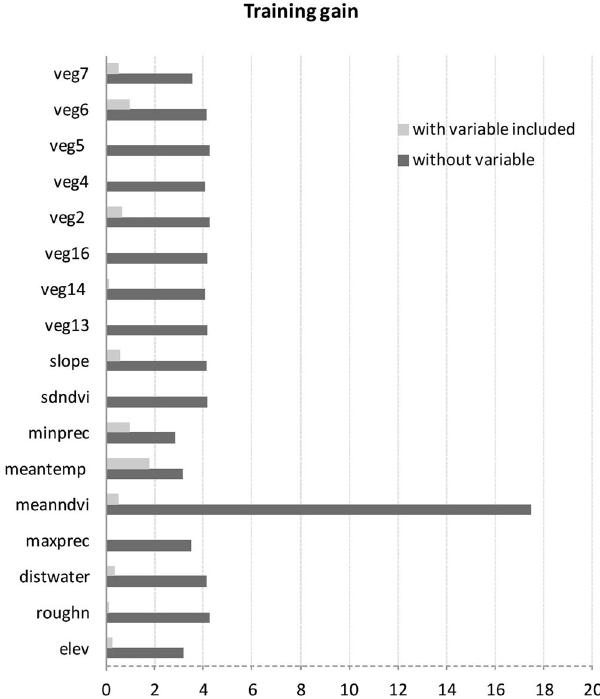
Figure 3. Training gain results (average of 100 models based on adult data only) for the explanatory variables used in model building. According to these, the most significant predictors of habitat suitability during the wintering period are minimum precipitation (minprec) and mean maximum temperature (meantemp). Elevation (elev) is also considered to be an important predictor of habitat suitability, since it was found highly correlated with mean maximum temperature and thus its effect might have been overshadowed by the latter. Variable abbreviations as in Supplementary Table